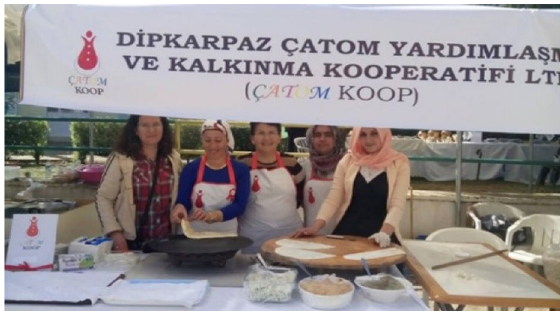
Fig. 4 Risokarpaso village. Risokarpaso ÇATOM